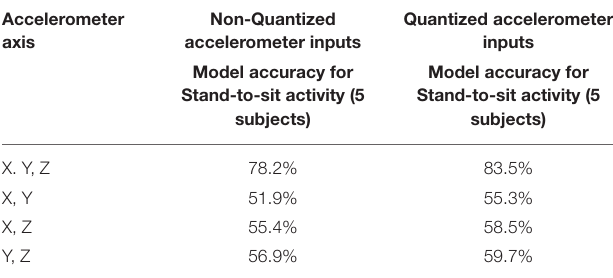
TABLE 4 Average accuracy observations for MEMS-CTRNN models for varying input dimension sizes and input quantization conditions. Accelerometer